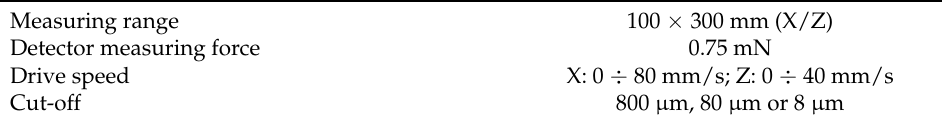
Figure 6. Surface roughness and profile study. Table 5. Roughness tester technical specifications.